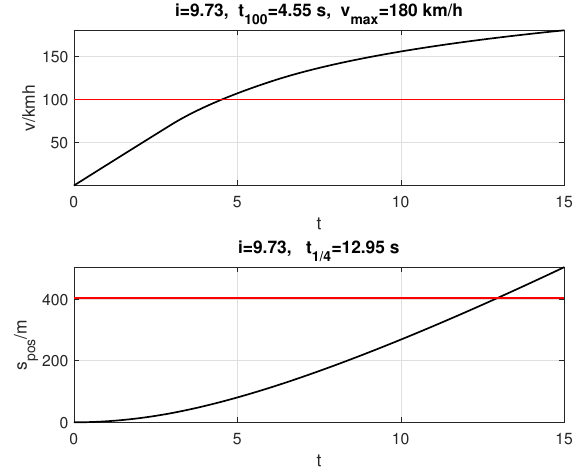
Figure 8. Performance of EV for nominal gear ratio.